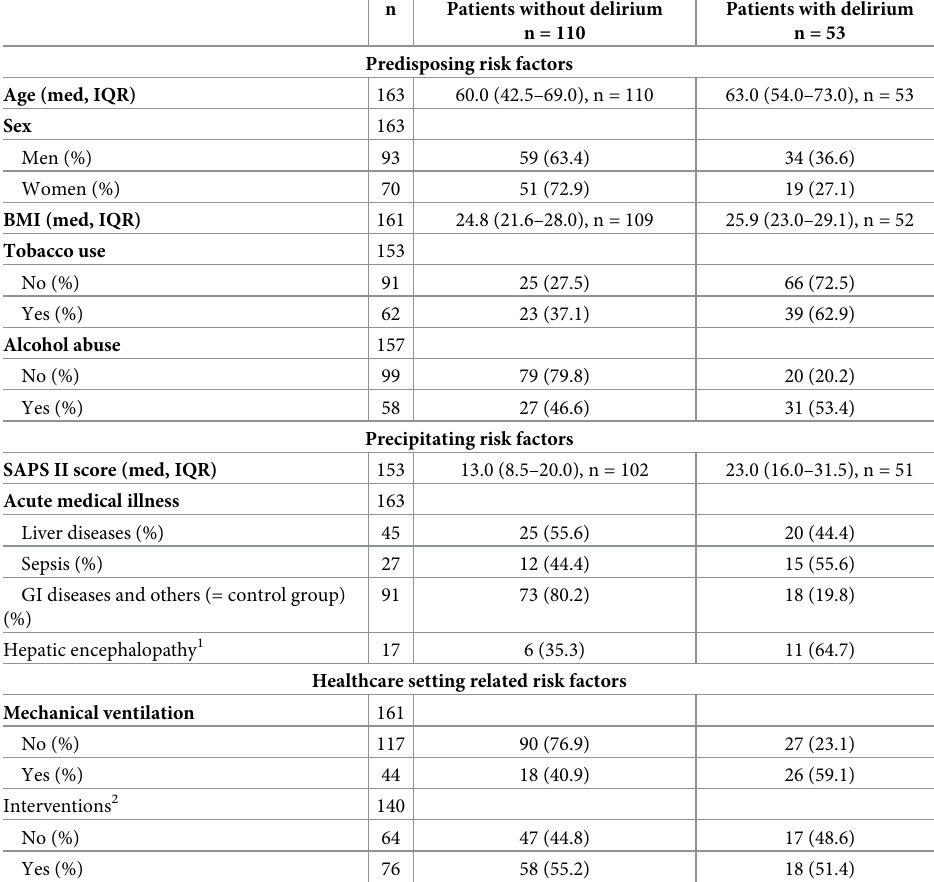
Table 1. Patient characteristics and risk